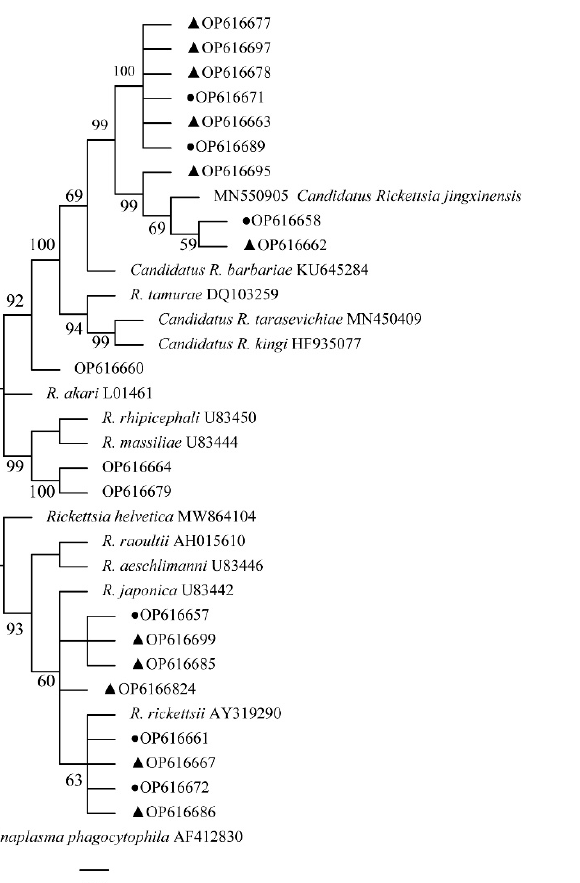
Figure 13. Phylogenetic tree of Anaplasma spp. in ticks based on partial 16S rDNA gene sequence similarity. The sequence from H. flava obtained in this study is indicated with a black triangle, and the sequence from H. longicornis obtained in this study is indicated with black dots. Sequences were aligned using the MEGA X (version 10.0) software package. Phylogenetic analysis was performed by the neighbor-joining method (NJ method), and bootstrap values were estimated for 1000 replicates. The Kimura two-parameter model was used as a substitution model for the calculation of the phylogenetic trees.